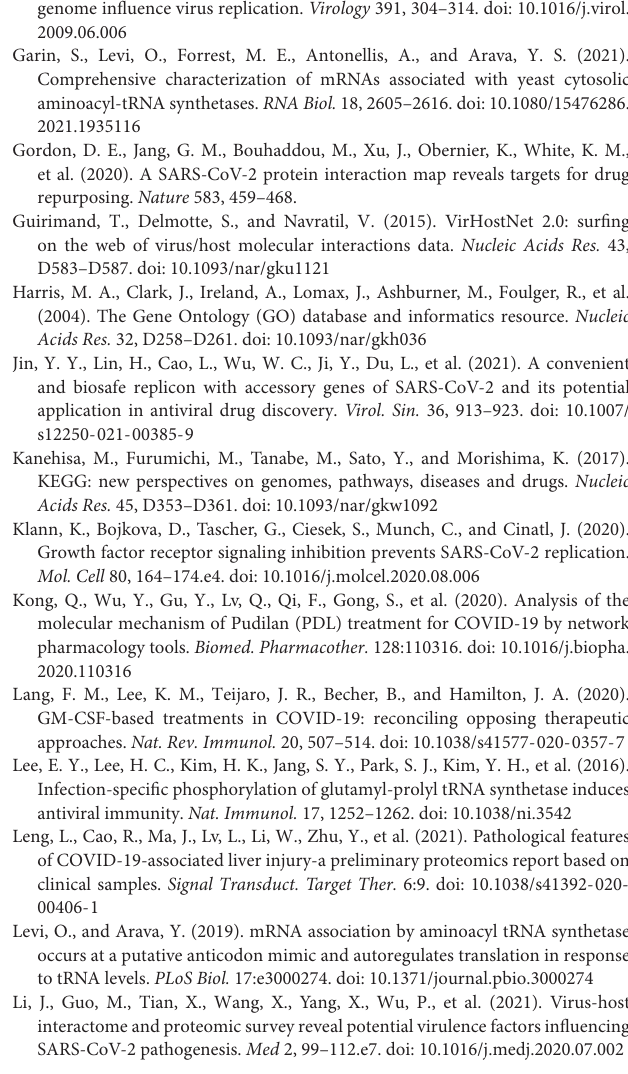
(A) Heatmap of cyto translation- and ribosome-related DEPs from different samples. The fold change in protein expression is indicated by color intensity, with red representing the upregulated DEPs and blue representing the downregulated DEPs. The DEPs include translation- and ribosome-related proteins (blue), and translation-related proteins (green). (B) The total protein levels of CARS1, DARS1 and HARS2. Ctrl, control; Inf, infection; hr, hour; ns, not significant (vs. mock-infected cells at 0 h). Supplementary Table 1 | Interactions between human aminoacyl-tRNA synthetases (aaRSs) and viruses. Supplementary Table 2 | Primers used for cloning. SARS-CoV-2-infected cell lines. Supplementary Table 5 | Significant IN nodes and their enriched GO terms and KEGG pathways in each